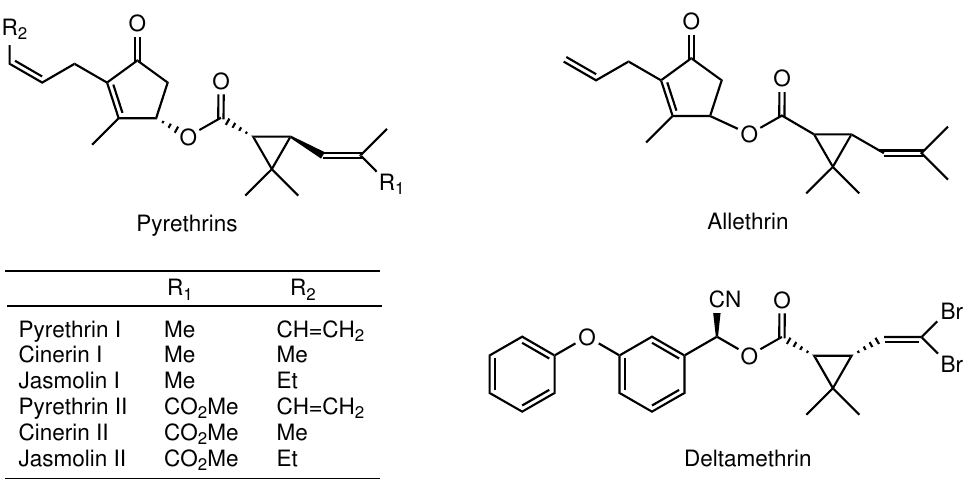
Figure 1. Chemical structures of the neurotoxic insecticides tested in dual-choice feeding assays. Genomic and transcriptomic studies have identified the key enzymes involved in pyrethrin biosynthesis and have elucidated a considerable part of their biosynthetic path- ways [10]. Pyrethrin biosynthetic genes are primarily expressed in the ovary during the pre-flowering stage and pyrethrin accumulation is induced by mechanical wounding and volatile organic compounds in the vegetative tissues. These regulatory mechanisms suggest pivotal roles of pyrethrins as endogenous defense molecules against insect herbivores. It has been found that the western flower thrips, Frankliniella occidentalis, that infest pyrethrum flowers avoid feeding on pyrethrin-treated leaves at those concentrations of pyrethrins that were close to the actual pyrethrin content in pyrethrum leaves [11]. This finding supports the belief that pyrethrins accumulated in plant tissues protect the pyrethrum plant by deterring insects from feeding on the plant. This deterrence is caused by the oral ingestion of pyrethrins prior to the expression of insecticidal actions. Similar feeding avoidance behaviors have been reported in whiteflies and aphids [12]. However, in the leaf-disk assays performed in these studies, the legs of the sucking insects were continuously in direct contact with the pyrethrin-coated leaf surfaces. This could elicit a repellent action, referred to as contact irritation, based on tarsal contact with pyrethrins [13–15], before any effect via ingestion occurs. In addition, these studies determined the feeding deterrence of pyrethrum oil obtained from an extract of dried and ground pyrethrum flower heads. The crude extracts of pyrethrum flowers contain a variety of terpenes at a concentration of approximately 10% [1,3]. Since phytoterpenes generally have the potential for repellent action in the vapor phase [16], constituents other than pyrethrins might have caused the decrease in feeding activity. Several pyrethroid insecticides have been shown to induce feeding deterrence in the larvae of lepidopteran [17–20] and coleopteran species [21–23], neither of which have tarsal chemoreceptors, indicating that the antifeedant activity is induced by the oral intake of the synthetic insecticides. However, there is no direct evidence indicating whether the feeding deterrence in insects is caused by any one or a combination of the six pyrethrin components of pyrethrum.